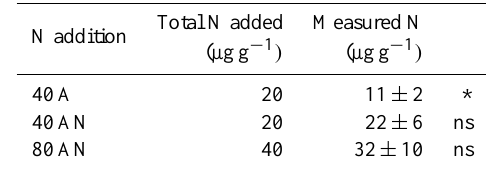
Fig. 2. C. ladanifer plant cover (a) and its response to the distinct N additions (Control, 40A, 40AN, and 80AN). Plant cover (%) was assessed on the first and second springs after the beginning of the N fertilizations, which allowed calculating its changes over time (see material and methods). Different letters refers to statistically sig- nificant differences between the two springs (ANOVA p < 0.1 fol- lowed by a Bonferroni test). There were no significant interactions between treatment and time ( p < 0.01). Values represent the mean ( n =3 experimental plots per treatment) ± SE. Table 2. Total N added to the soil over the first year of experiment (the first three N additions: January, April and August 2007) and the soil inorganic N concentrations in relation to the control determined in autumn (measured N) according to the N treatments (40A, 40AN and